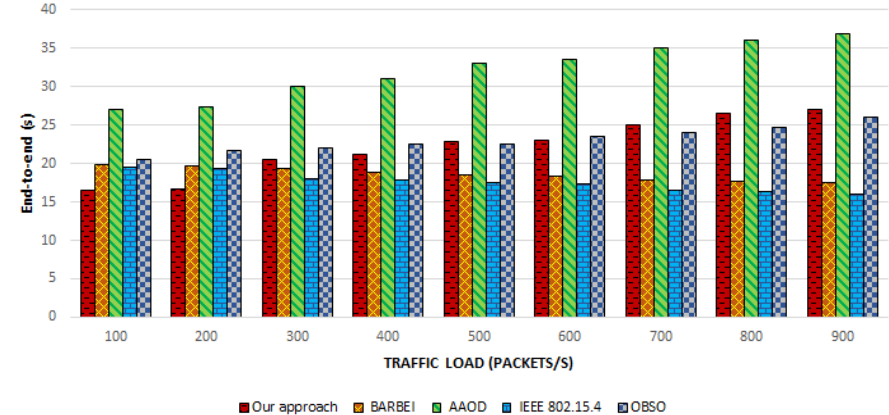
Figure 7. End-to-end delay.